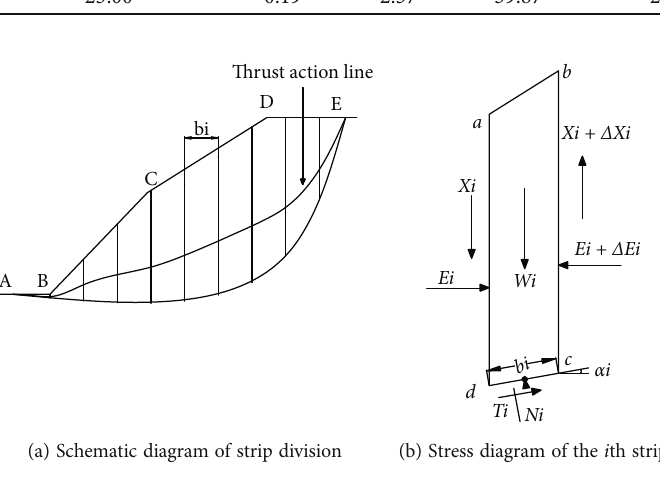
Figure 3: Schematic diagram of Janbu method calculation model.